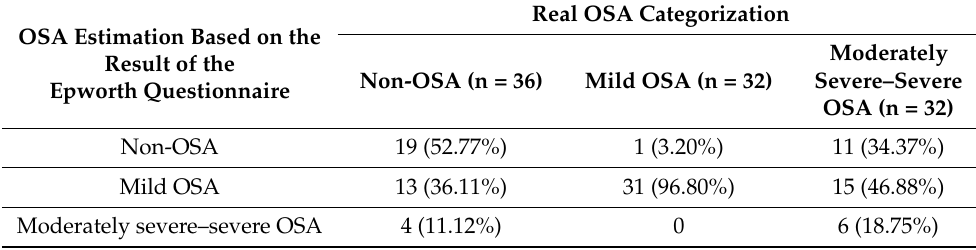
Table 9. OSA category prediction based on the result of the Epworth questionnaire (the table shows the number of cases per 100 patients and the percentage distribution of scores within OSA categories). OSA: obstructive sleep apnoea.